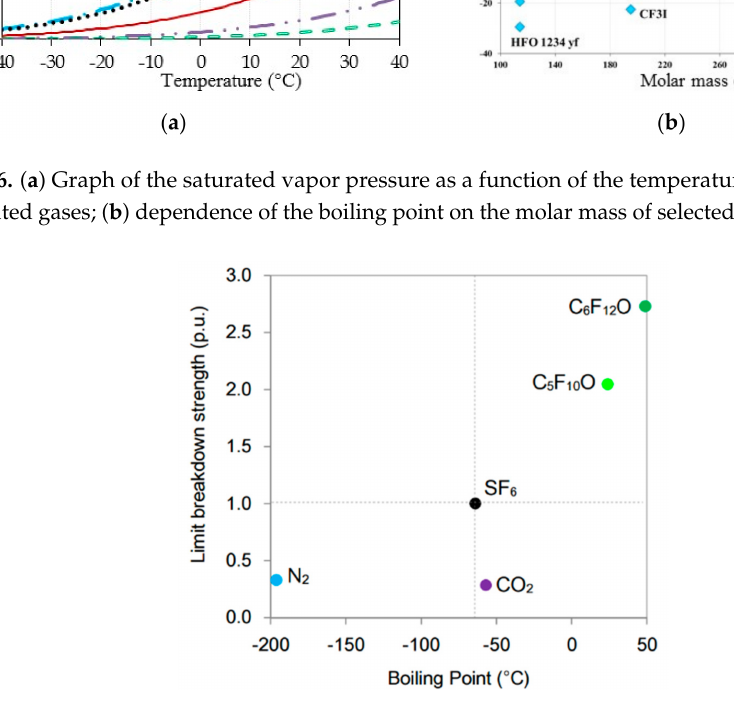
Figure 7. Relative dielectric strength as a function of boiling temperature at 1 bar